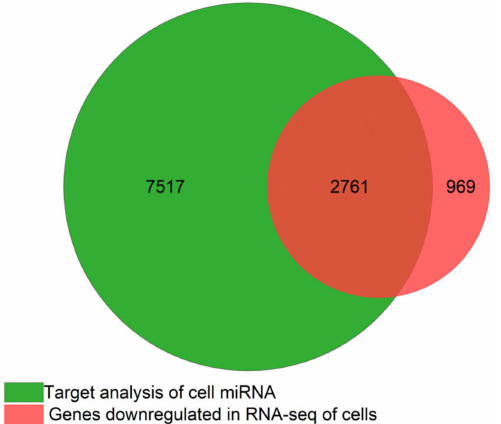
Figure 13. Venn diagram of the miRNA target from the top 15 cellular miRNA vs. RNA downregu- lated in mRNA-seq in astrocytes without FBS compared to the control grown in